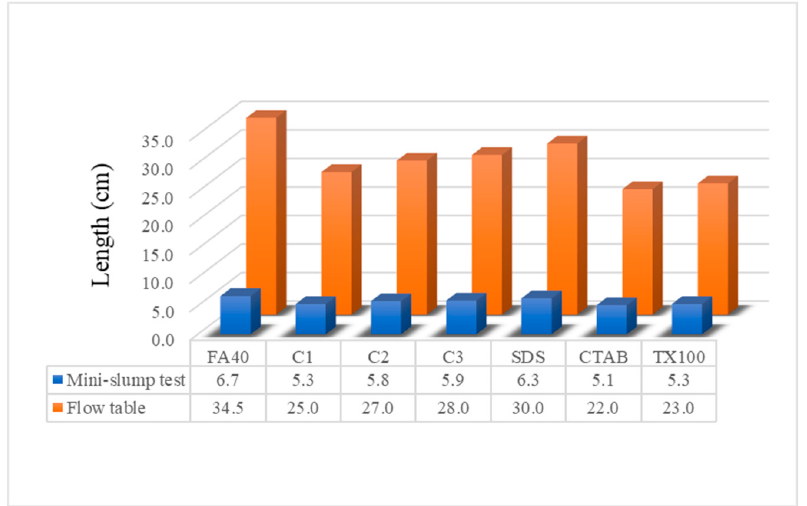
Figure 8. Effect of α -Fe 2 O 3 nanoparticles on mini-slump test and flow table of FA blended ce- ment mortar.